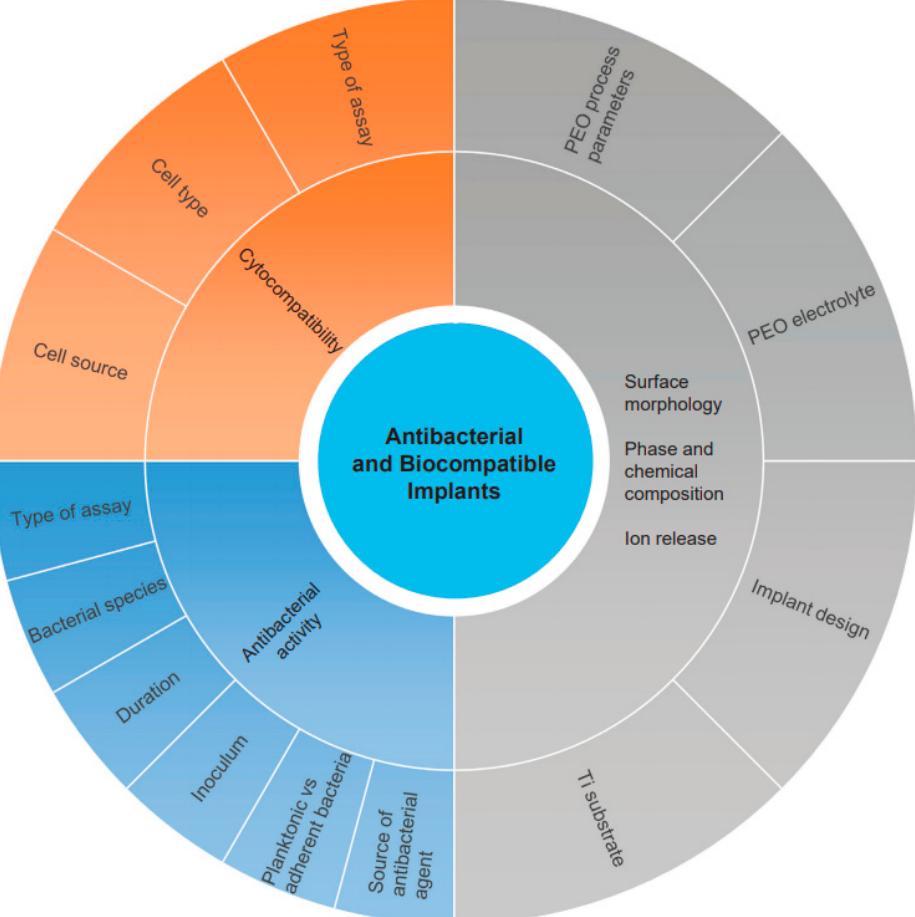
Figure 1. A graphical presentation of the outline of this systematic review.